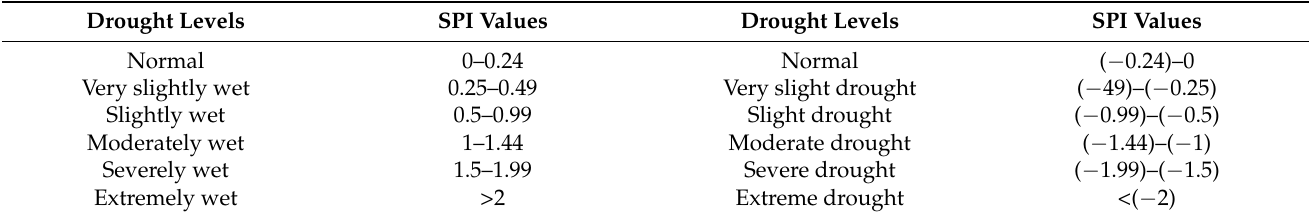
Table 1. The classification of drought and wet according to the SPI